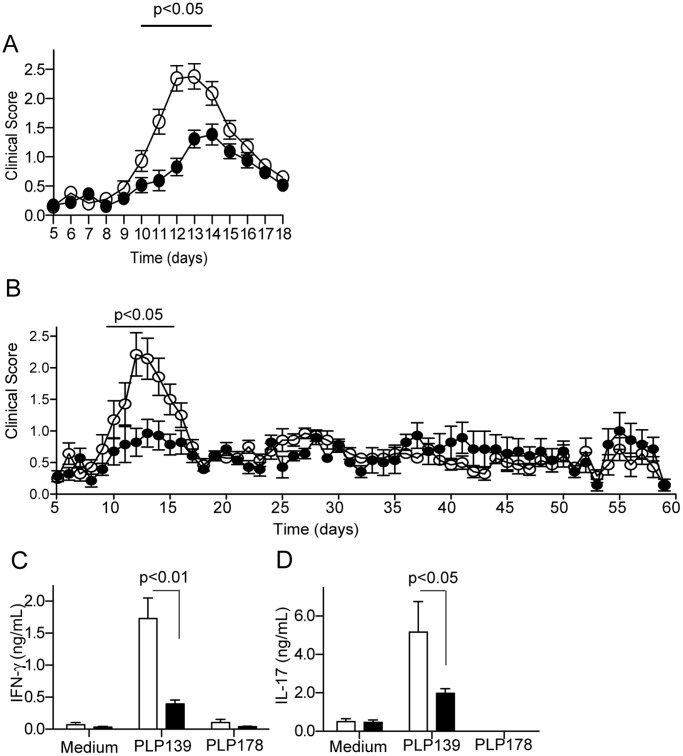
TLR7 ligand treatment reduced clinical severity, and T cell responses of EAE mice.(A) SJL/J mice were i.p. immunized with PLP139–151 in CFA with Ptx. Mice (n = 26/group) received 150 nmol/animal 1V136 or vehicle s.c. daily from day 6 onward. The mice were scored for disease and the data were pooled from four independent experiments. Bar indicates p<0.05 by two-way ANOVA with Bonferroni post hoc tests. (B) SJL mice were immunized as above (n = 14/group) and treated from day 5 to 18 with 150 nmol/animal 1V136 or vehicle s.c. and disease was monitored up to 60 days. Data are pooled from 2 independent experiments and the bar indicates p<0.05 by two-way ANOVA with Bonferroni post hoc tests. (C, D) Splenocytes obtained from vehicle- (n = 5) and 1V136-treated (n = 5) SJL/J EAE mice at 19 days were restimulated in vitro with PLP139–151 peptide for 3 days. Levels of IFN-γ (C), and IL-17 (D) in the supernatants were determined by ELISA. Data shown are means ± SEM and are representative of three independent experiments that showed similar trends. p<0.05 compared vehicle-treated group by Student t test.